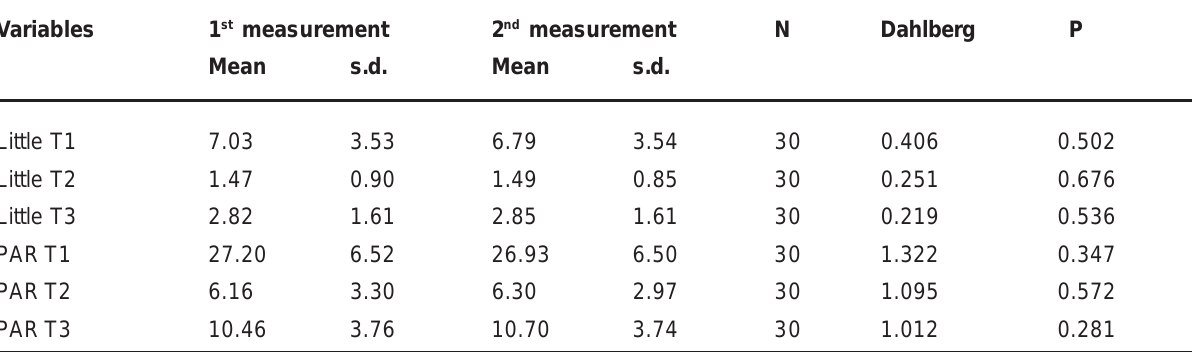
TABLE 1- Casual and systematic errors between the 1 st and 2 nd measurements